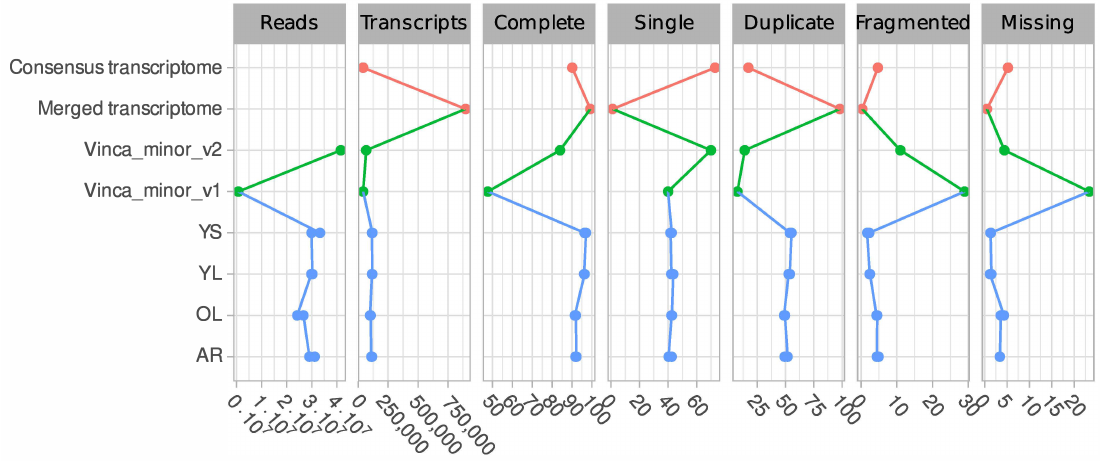
Figure 2. Comparison of V. minor transcriptomes in terms of number of generated reads, number of assembled transcripts and BUSCO evaluation scores (% complete, single, duplicated, fragmented and missing). Data sources are depicted as di ff erent colors with blue generated in this study, green obtained from previously published data and orange derived from our generated combined